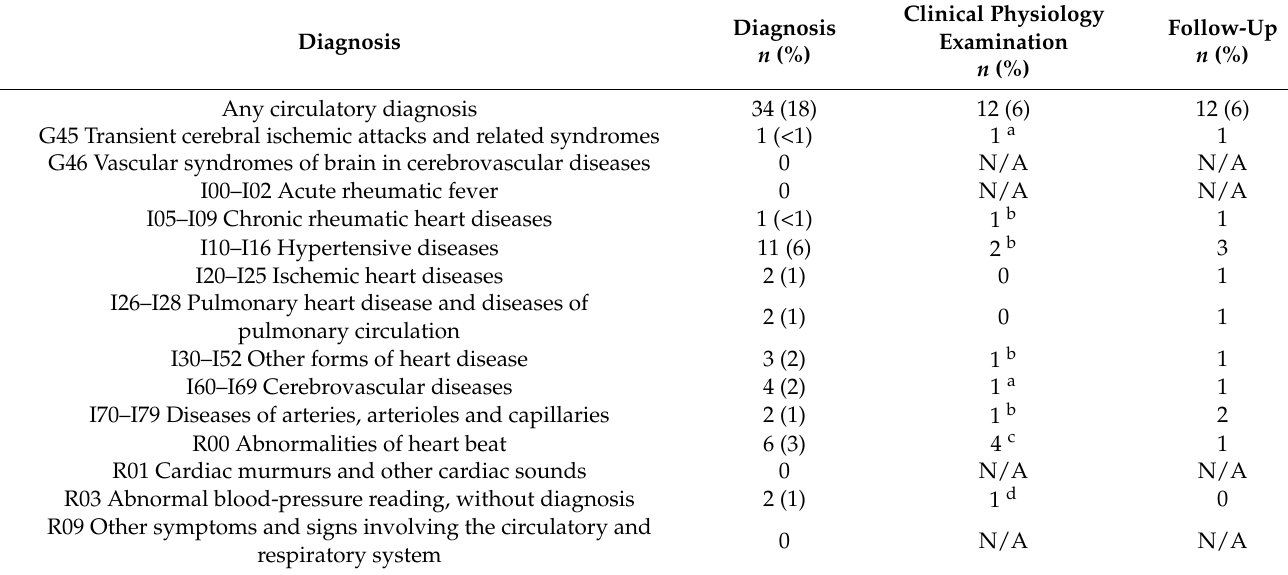
Table 2. Registered diagnoses and healthcare utilization for circulatory conditions.